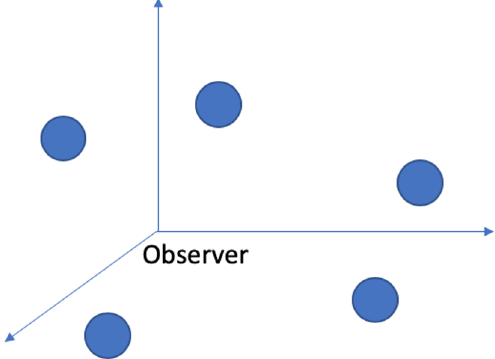
Figure 16 . Spatial distribution of the GW in de Sitter space at | τ | (cid:29) | τ ? | . like a bunch of solid balls scattered in the space with the comoving radius around | τ shown in figure